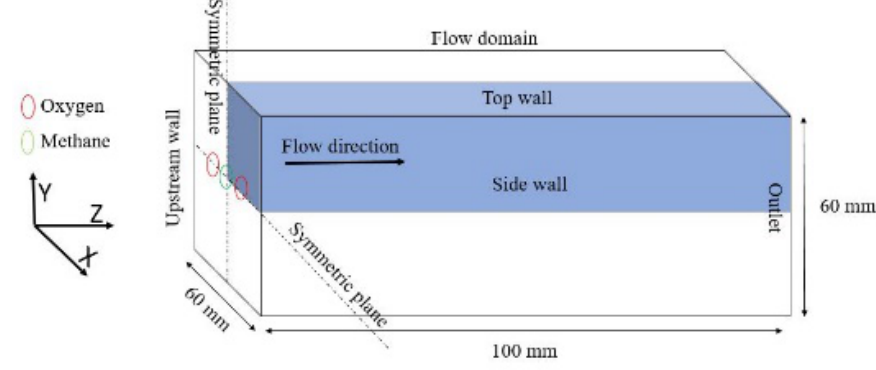
Figure 3. Flow domain, and numerical domain.